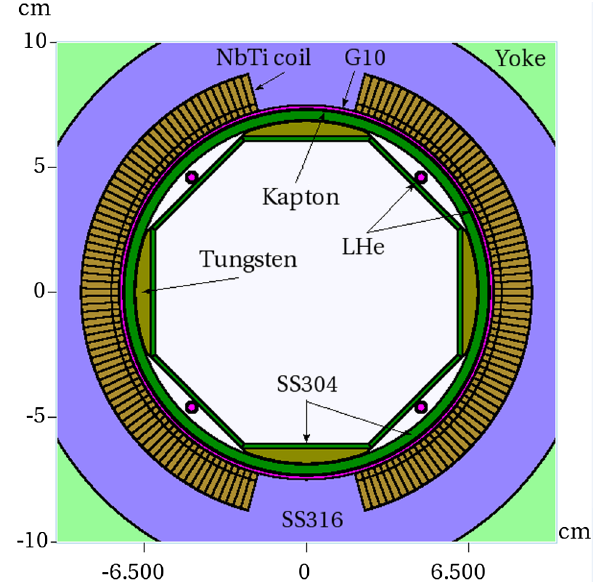
(right).FIG. 5. Cross-sectional view of the FLUKA - MARS model in the central part of the D1 dipole. The coil is homogenized and subdivided azimuthally and radially for